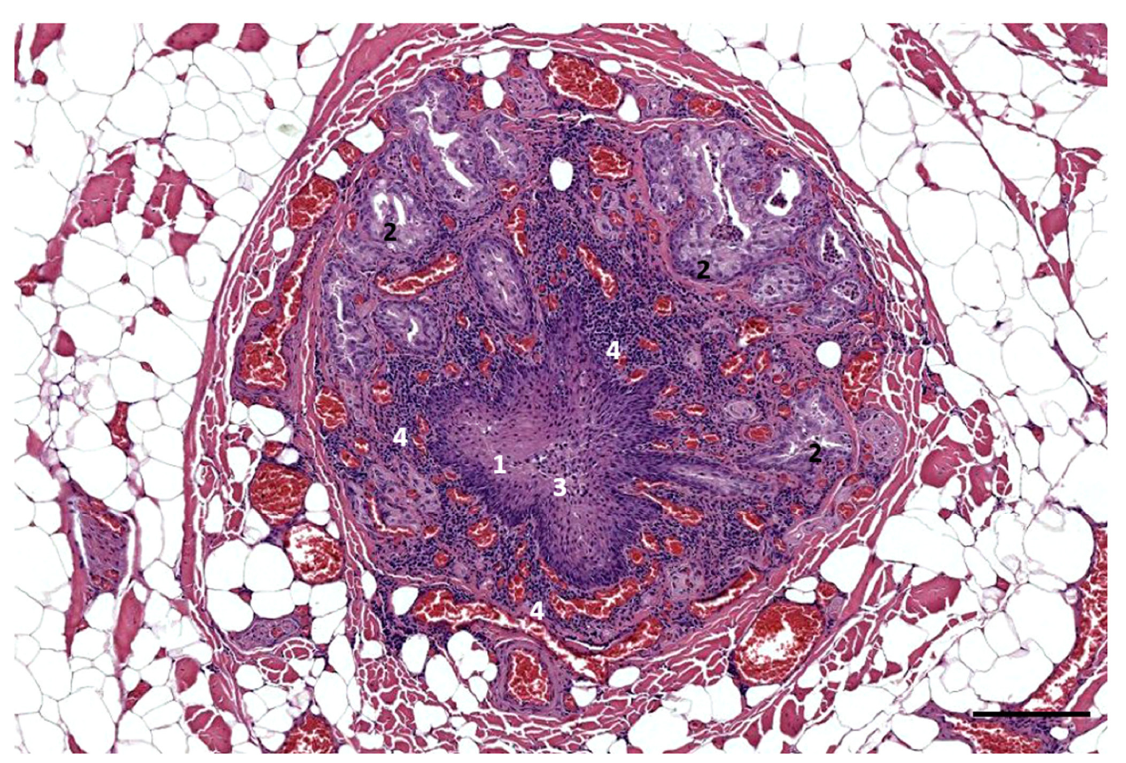
Figure A1. A histological image (HE staining) of a transverse section through the external ear canal (1) of a striped dolphin (293/18) at the level of the glands (2). Note the inflammation with a compressed ear canal lumen that is filled with inflammatory cells and sloughed epithelial cells (3), the circummeatal presence of mononuclear cells (4) and the overall congestion of the tissue. Scale bar = 200 µm.